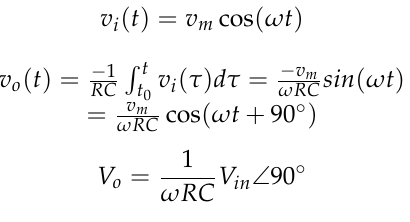
Figure 2. Diagram of the circuit for measuring transformer current and integrating voltage. As indicated by Equation (7), the input v i of the inverting integrator circuit was a sinusoidal signal (V) with a magnitude v m , angle frequency ω , and phase angle starting at the maximum voltage. The output signal v o was calculated using Equation (8) and the phasor V o of the output signal was calculated using Equation